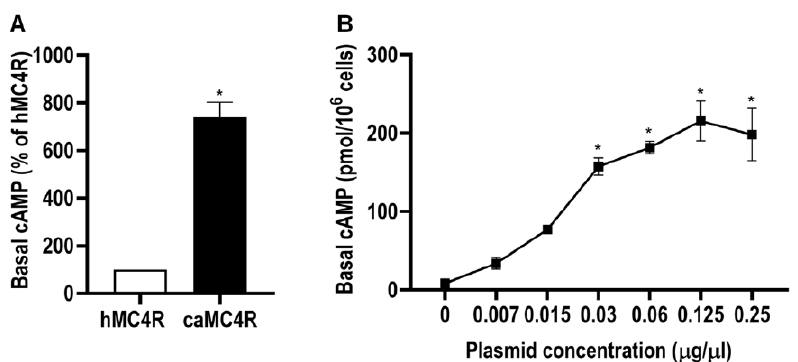
Figure 9. Constitutive activities of caMC4R in cAMP signaling pathway. HEK293T cells were transiently transfected with 0.25 µ g/ µ L hMC4R or caMC4R to compare their basal cAMP activity ( A ) or transfected with increasing concentrations of caMC4R ( B ). Data were expressed as mean ± SEM ( n ≥ 3). Asterisk (*) showed significant difference ( p < 0.05) of basal cAMP level compared with respective control group (Student’s t -test in A and one-way ANOVA followed by Tukey-test in B).